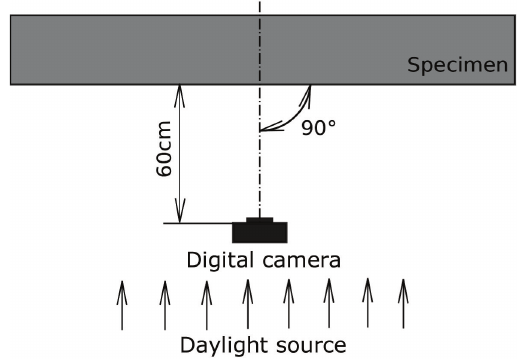
Fig. 4. The typical experimental setup for digital image correla- tion (top